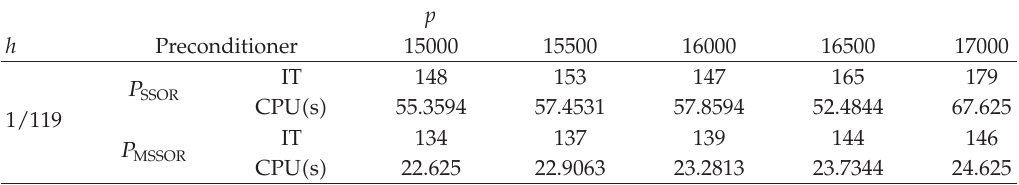
Table 4: Iteration numbers for the two-dimensional Helmholtz equations for h (cid:10) 1 / 119 and q (cid:10) 2000, using COCG with the preconditioner P SSOR and P MSSOR